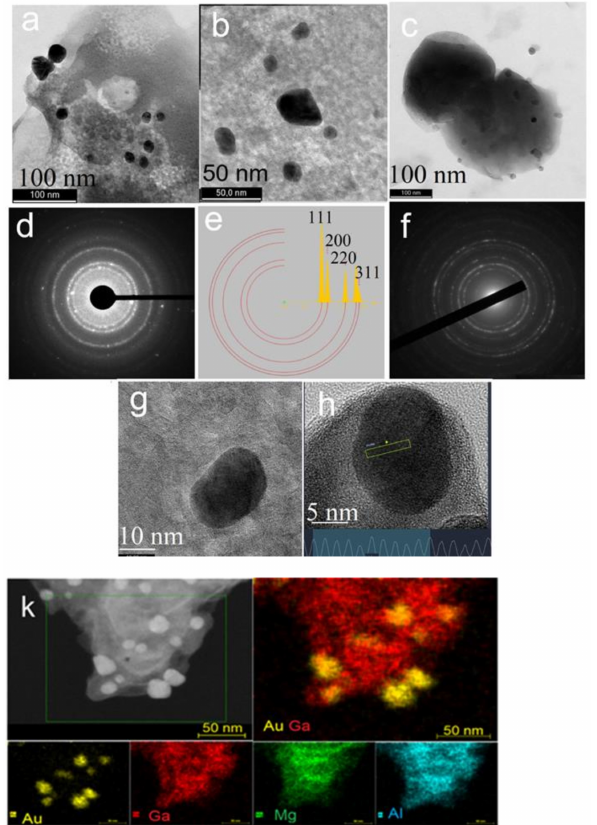
Figure 3. ( a ) TEM image of Au_MgGaAl; ( b ) Higher magnification of TEM image of Au_MgGaAl; ( c ) low magnification TEM image of Ag_MgGaAl; ( d,e ) SAED pattern of Au_MgGaAl; ( f ) SAED pattern of Ag_MgGaAl; ( g ) HRTEM image of Ag_MgGaAl; ( h ) HRTEM image of a single nanoparticle on Au_MgGaAl with identification of the crystal plane of gold; ( k ) HAADF STEM image of Au_MgGaAl and the corresponding STEM-EDS element